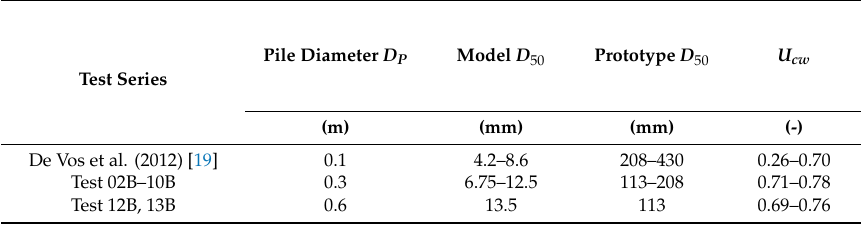
Table 6. The median armor material sizes D 50 used in di ff erent scale